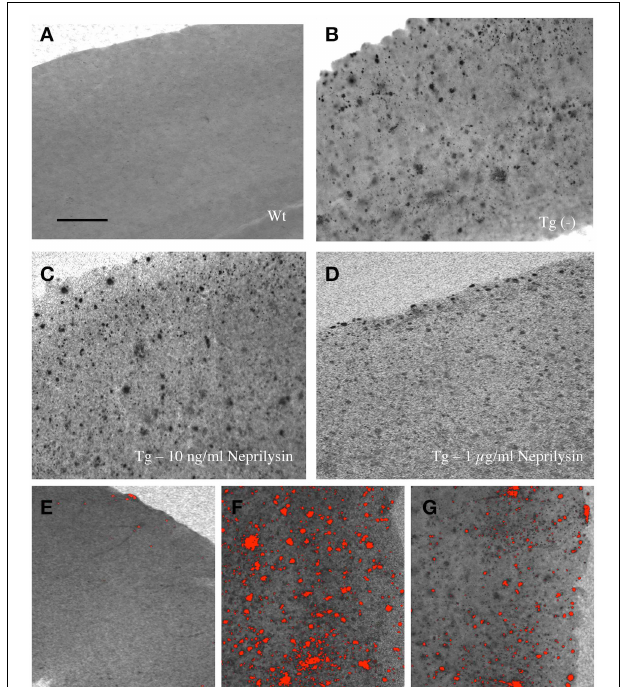
FIGURE 4 | Effects of neprilysin on beta-amyloid (A β ) plaques in 9 month old amyloid-precursor protein_SDI mouse model vibrosections and computer-assisted analysis (E-G). Organotypic vibrosections of 9 month old wildtype (Wt, A,E ) or transgenic (Tg, B–D,F,G ) mice were prepared (120 µ m thick) and cultured for 2 weeks without (A,B) or with 10ng/ml (C) or 1 µ g/ml (D) neprilysin, then fixed and immunohistochemically stained for beta-amyloid (A–G) . Note the decreased number of plaques in vibrosections incubated with 1 µ g/ml recombinant neprilysin for 2 weeks (D) . The number of plaques was counted using computer-assisted imaging (E–G) , showing no plaques in Wt vibrosections (E) , a high number of plaques in Tg